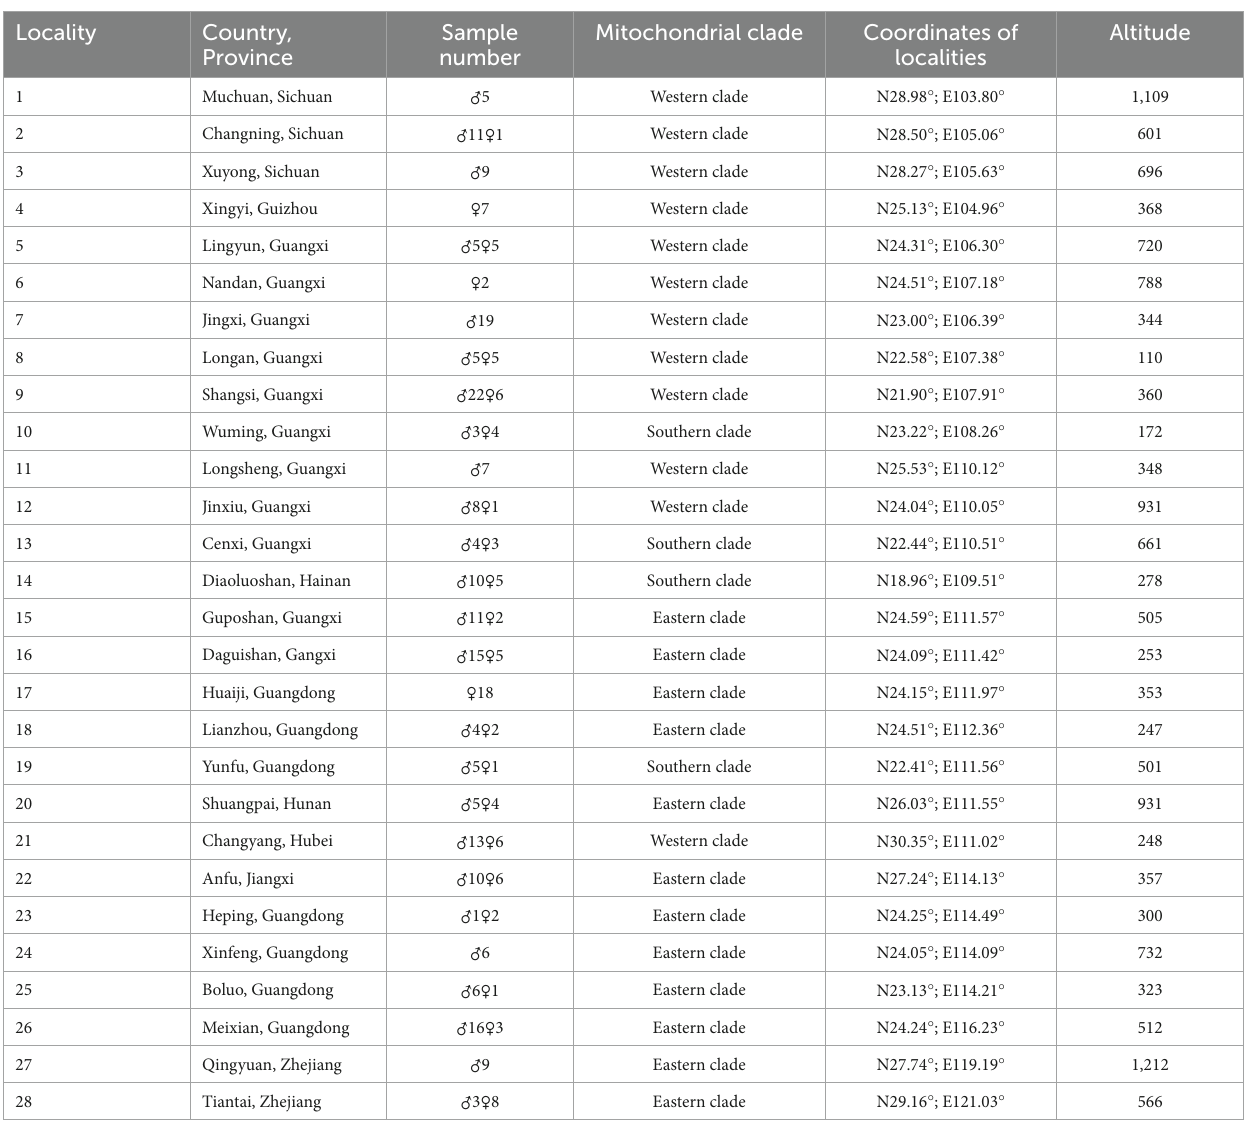
TABLE 1 Details of 28 populations of Odorrana graminea sensu stricto.